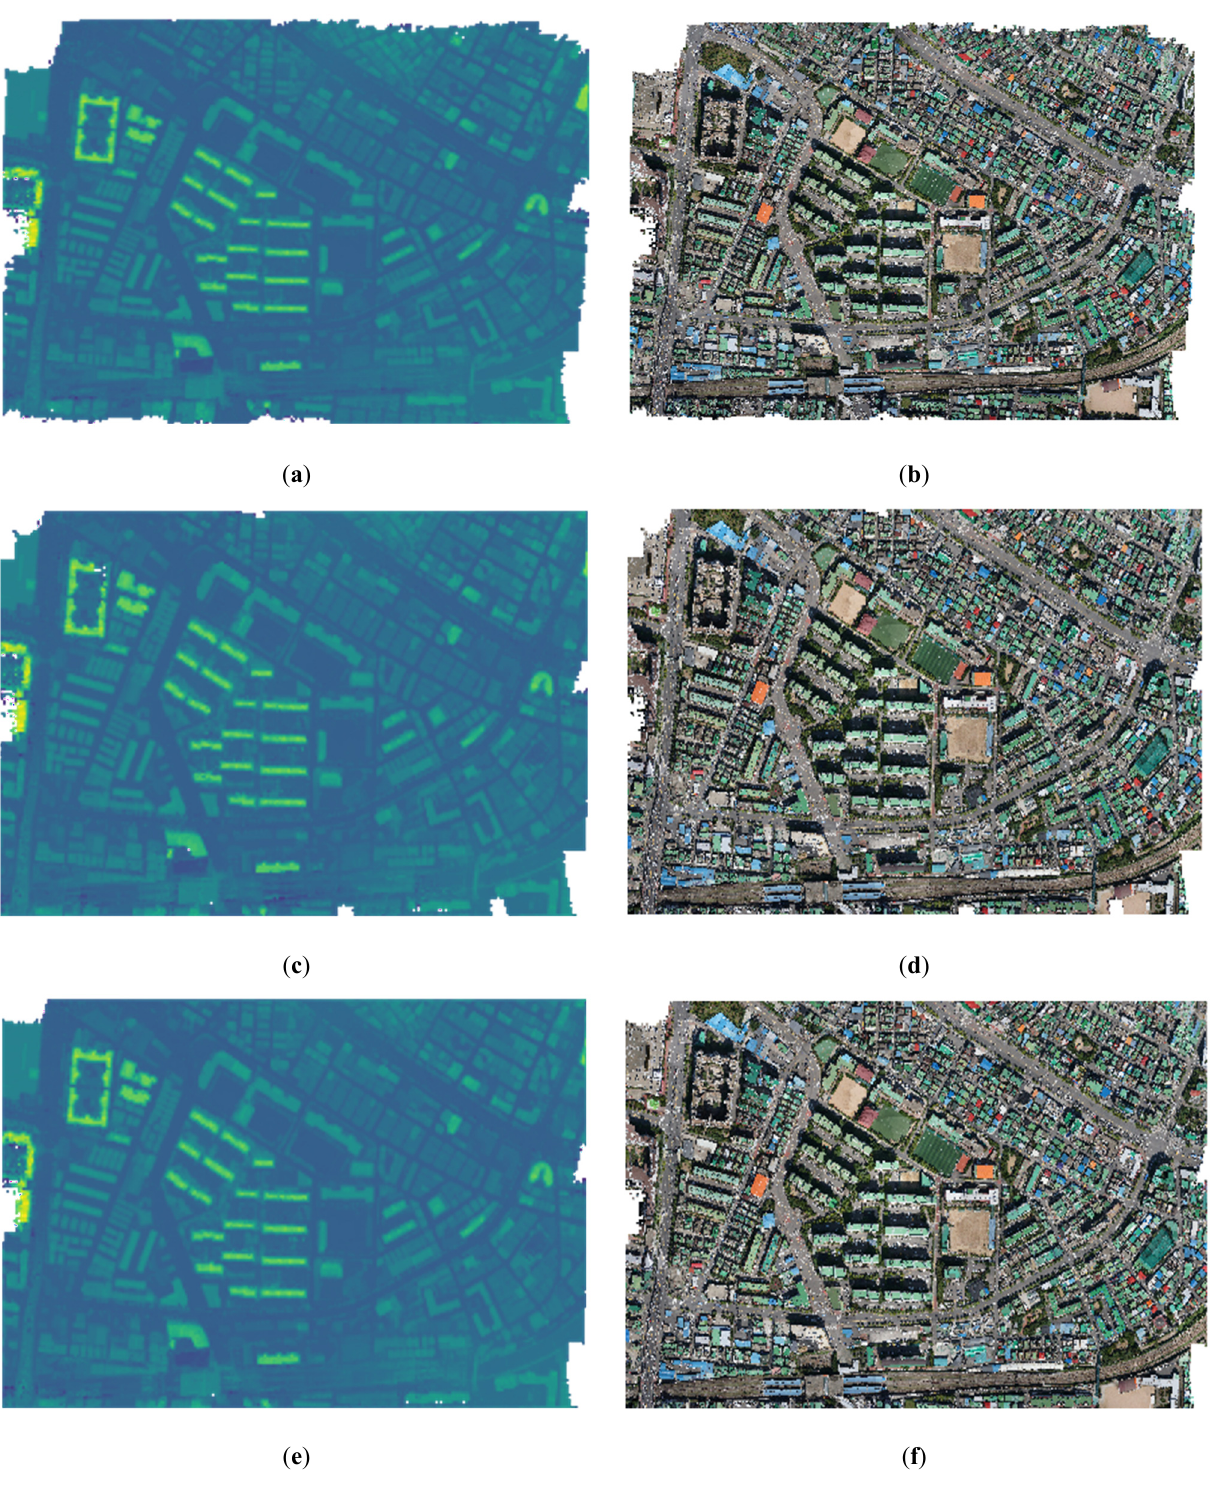
Figure 10. Digital surface models (left) and ortho-mosaic images (right) generated by each type of pair selection: ( a , b ) were generated by adjacent-pair selection; ( c , d ) were generated by minimum-pair selection; while ( e , f ) were generated with most accurate–pair selection .